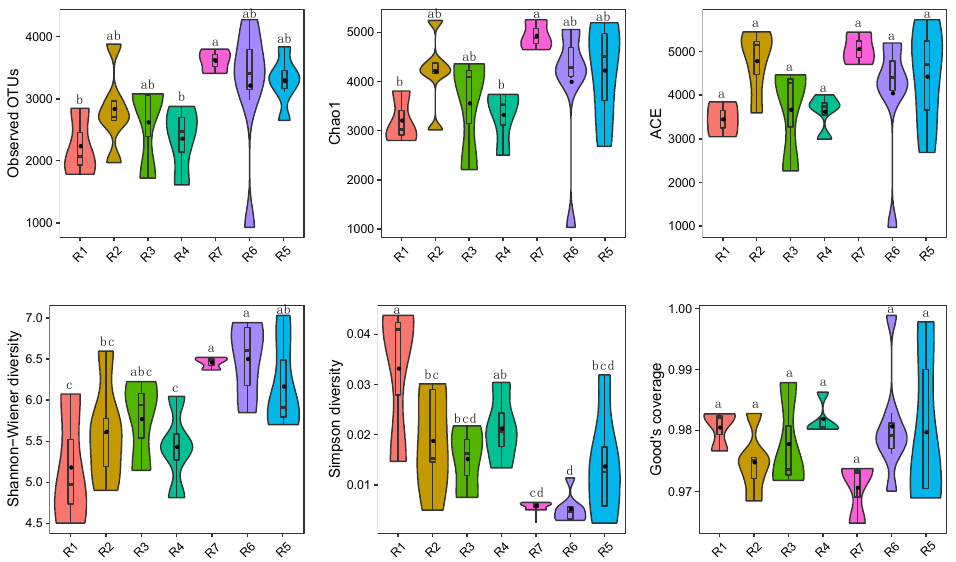
Figure 2. Comparison of alpha diversity among different river reaches. Statistical significances are indicated by letters above the boxes. Boxes with the same letters (like a and a, a and ab) represent no significant difference ( p > 0.05), while with different letters (like a and b, a and bc) differ significantly ( p < 0.05) between paired reaches.